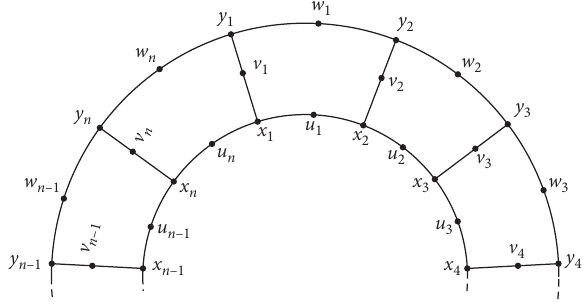
Figure 4: Prism graph. Y